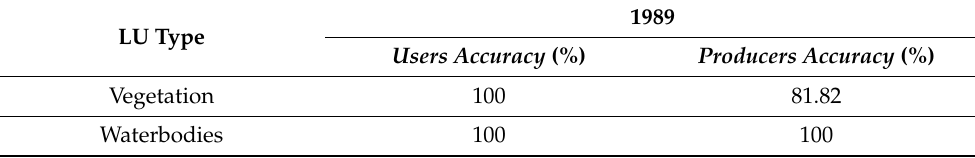
Table A3. User accuracy and overall accuracy for the LU/LC types in